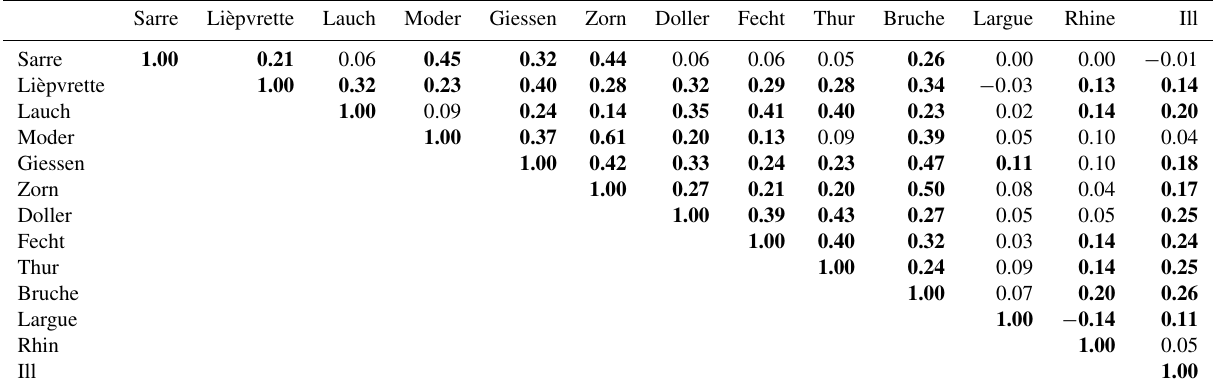
Table 7. Pearson’s cross moment-product coefficient between individual rivers by event presence and absence sequences. Events with and without water overflow are considered together. Bold values are significantly non-zero at the 0.05 significance level on the basis of a Student